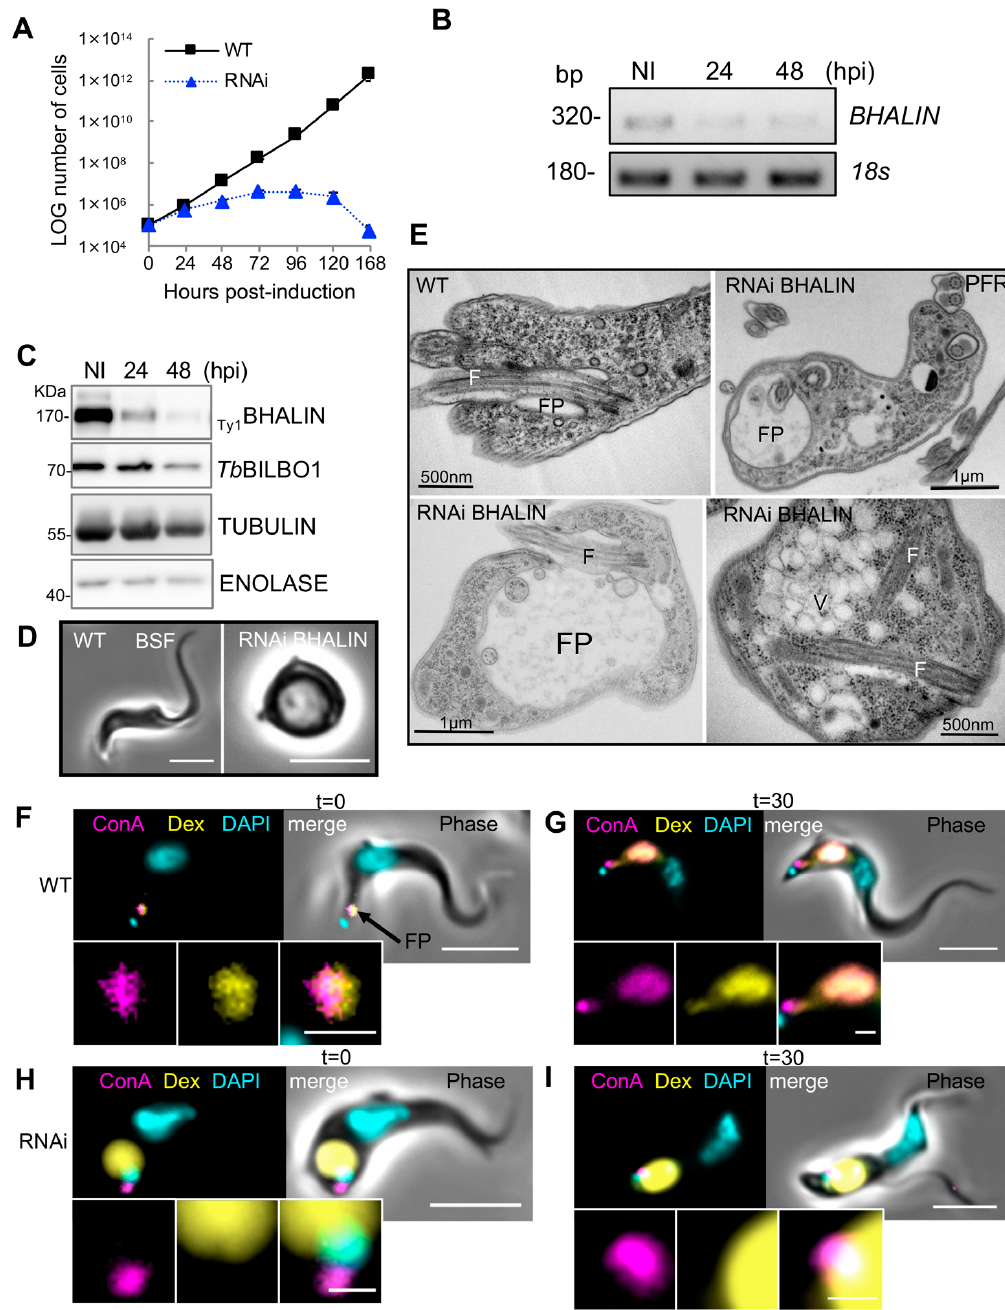
Figure 5. Knockdown of BHALIN in BSF leads to a “BigEye” phenotype and rapid cell death. ( A ) Growth curve of WT and BHALIN RNAi induced trypanosomes. ( B ) Semi-quantitative RT-PCR showing the decrease in BHALIN mRNA levels after RNA induction. ( C ) Western blot of NI and induced BHALIN RNAi cells over 48 h; tubulin and enolase were used as controls. ( D ) Phase contrast micrographs of BSF trypanosomes from WT cell line and 24 h post-induction of RNAi knockdown of BHALIN; scale bar = 5 µ m. ( E ) Transmission electron micrographs of BSF trypanosomes from WT cell line and 24 h post-induction of RNAi induced against BHALIN knockdown. F = flagellum, FP = flagellar pocket, PFR = paraflagellar rod, V = vesicles. ( F ) A WT BSF trypanosome at time = 0 showing loading of fluorescent dyes (ConA and Dextran) in the flagellar pocket (FP). ( G ) A WT BSF trypanosome after 37 min at 37 ◦ C showing uptake of dyes into the cell endomembrane and lysosome system. ( H ) A BSF cell induced for RNAi BHALIN knockdown (17 h) showing dextran (yellow) filling an enlarged FP and ConA (magenta) outside the FP. ( I ) A BSF trypanosomes induced for RNAi BHALIN 17 h after 30 min at 37 ◦ C showing no entry of the dyes into the cell body. Scale bars = 5 µ m, insets = 1 µ